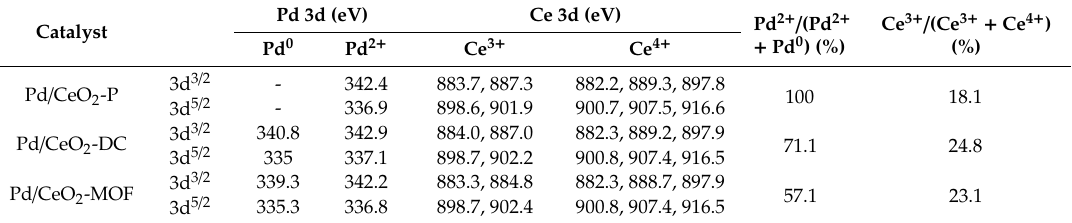
Table 2. Summary table of XPS characterization result of